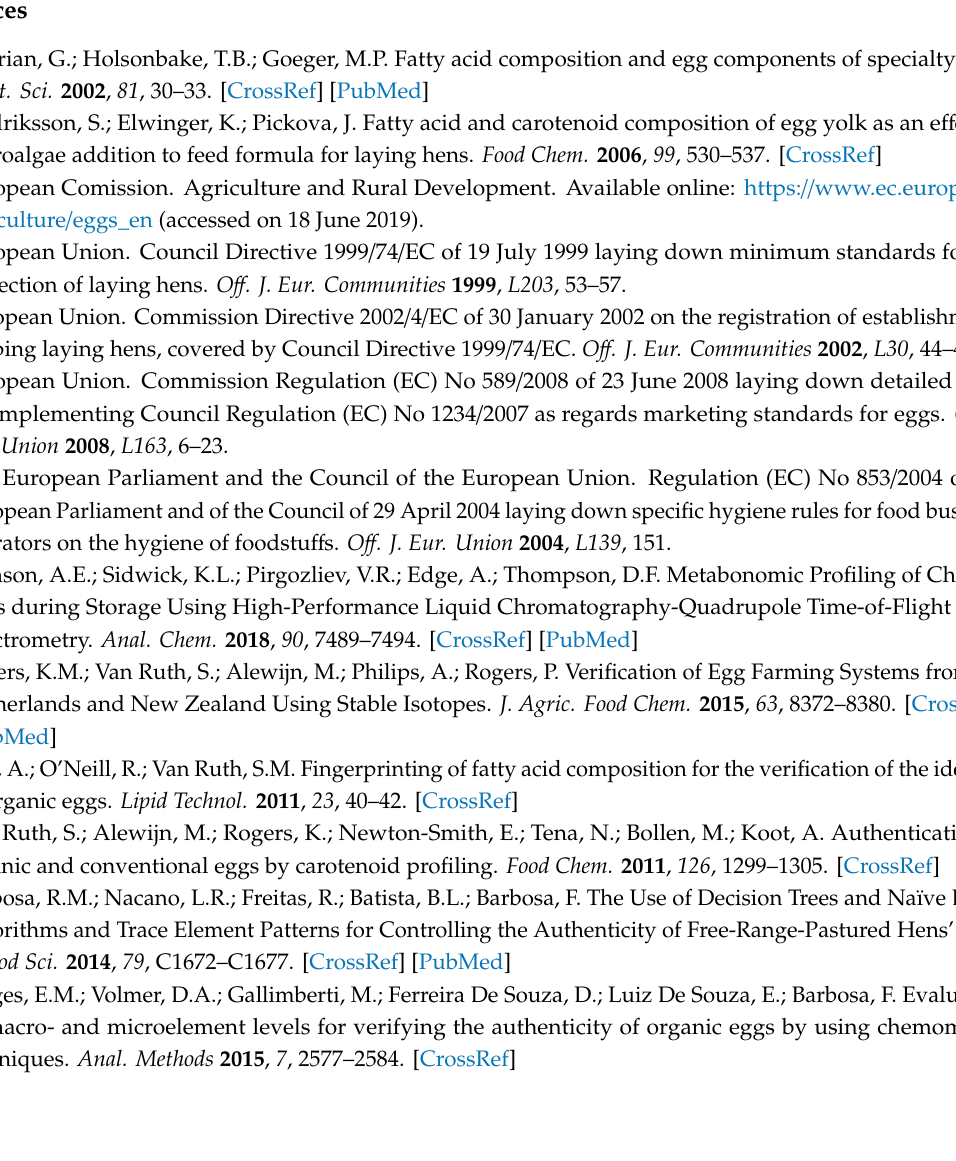
Figure S1: PLS-DA scores plots of LV1 vs. LV2 for M and L size eggs when using HPLC-UV chromatographic fingerprints registered at 250 nm as chemical descriptors. Figure S2: Latent variable number vs. CV classification error average plots for the built PLS-DA models of: (A) O vs. FR, B and C eggs, (B) FR vs. B and C, and (C) B vs.